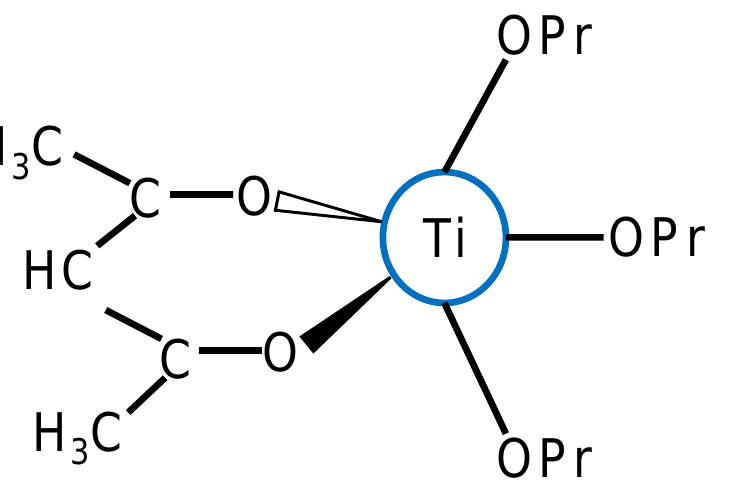
Figure 6. Structural formula of an oligomer formed between a titanium (IV) propoxide and acety- lacetone.